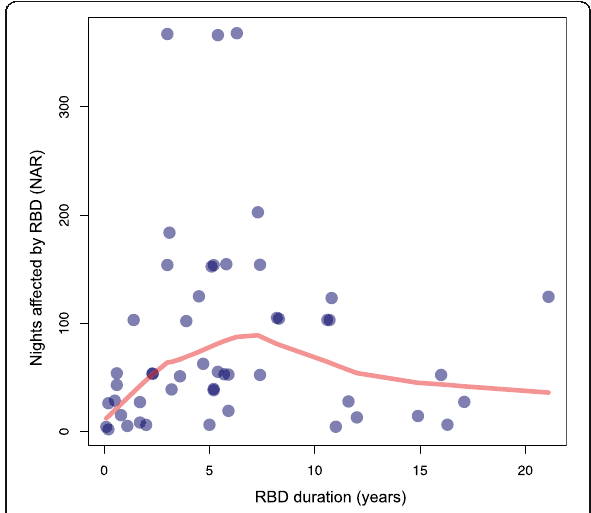
Fig. 2 RBD frequencies and the relation with the RBD duration. A scatter plot of RBD frequencies is shown. The x-axis denotes the duration of RBD in years. The y-axis denotes the frequency of RBD symptoms in NAR units. The blue spots represent RBD duration and RBD symptom frequency at the first visit to our sleep clinic. For better understanding of the RBD symptom frequency changes, trend is indicated with a red line, which was generated using the locally weighted scatterplot smoothing